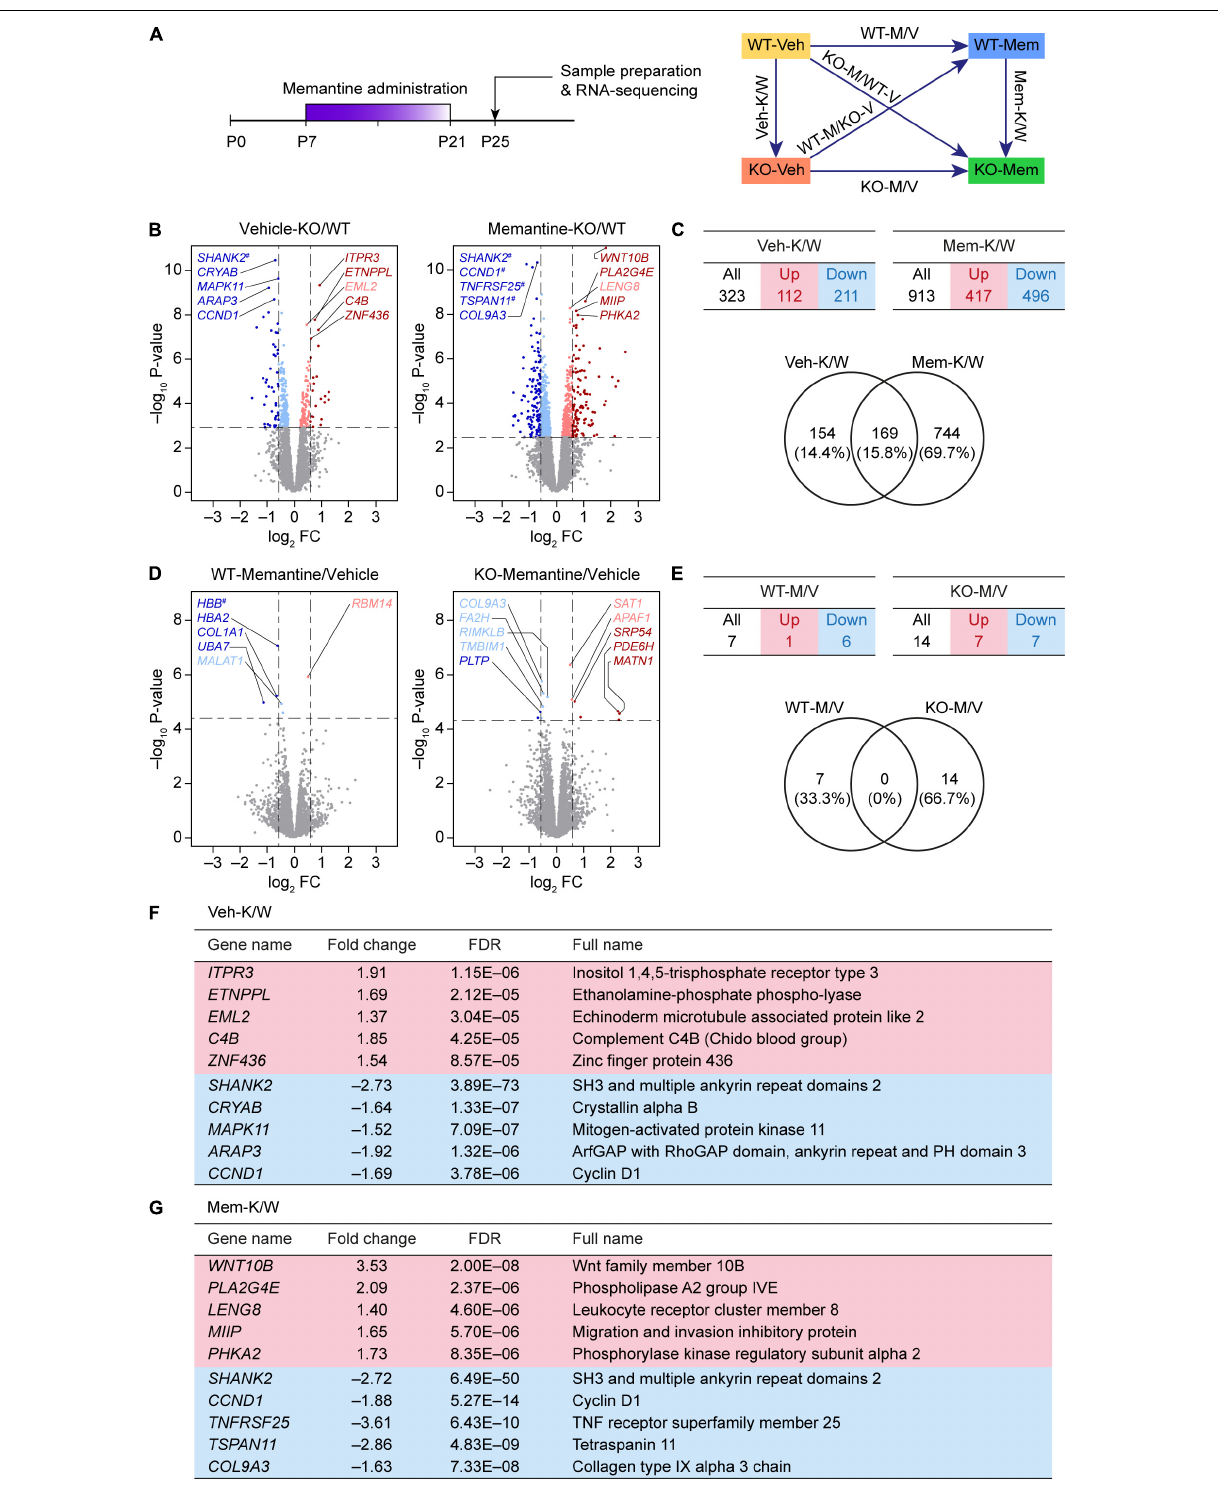
FIGURE 1 | Differentially expressed gene analyses based on RNA-Seq results from WT-V, WT-M, Shank2 -KO-V, and Shank2 -KO-M mice. (A) Schematic depiction of RNA-Seq analyses employing vehicle (Veh)- or memantine (Mem)-treated WT and Shank2 -KO mice, and DEG and GSEA analyses comparing the effects of memantine treatment between WT and KO mice, or differences between WT and KO mice under vehicle- and memantine-treatment conditions. (B,C) Volcano plot and summary table for DEGs from Veh-KO/WT (Veh-K/W) and memantine-KO/WT (Mem-K/W) transcripts, and Venn diagram showing the overlap between DEGs from Veh-K/W and Mem-K/W transcripts. ( n = 3 mice for WT-V, WT-M, KO-V, and KO-M; dotted lines indicate adjusted p -value < 0.05 or |FC| > 1.5; DEGs